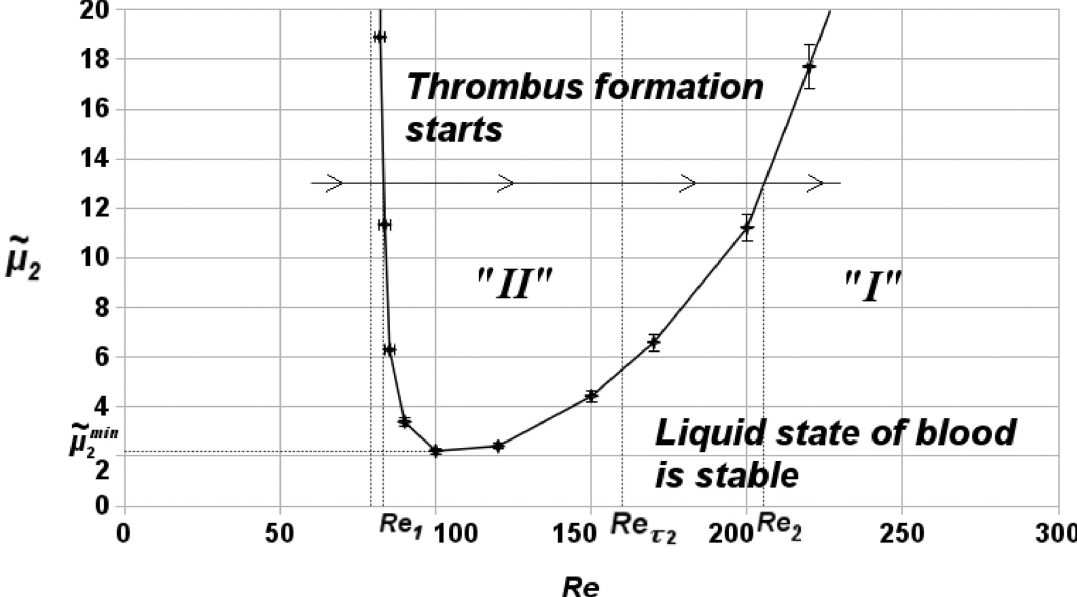
~ m 2 is the non- ~ ~ — the permeability of the vessel m 2 and m min